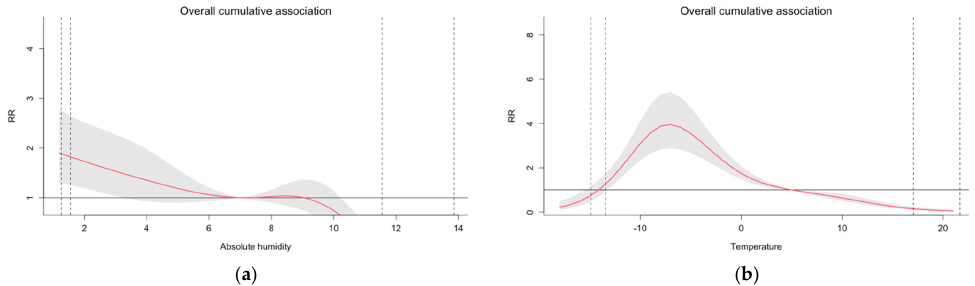
Figure 5. Overall associations between ( a ) absolute humidity and COVID-19 morbidity incidence with the reference value of AH = 7 g/m 3 and ( b ), temperature and COVID-19 morbidity, with the reference value of T = +5 °C in the Helsinki-Uusimaa Hospital District (HUS) from 1 August 2020 until 31 May 2021. The figures present the overall cumulative RR across all lags for Model 2 with three fixed knots for the exposure variables. The grey area illustrates the 95%-CI (confidence interval) of the modelled relationship. The vertical lines in the figures present the 1, 2.5 and 97.5 and 99 percentiles of the daily mean distribution of the variable in question.